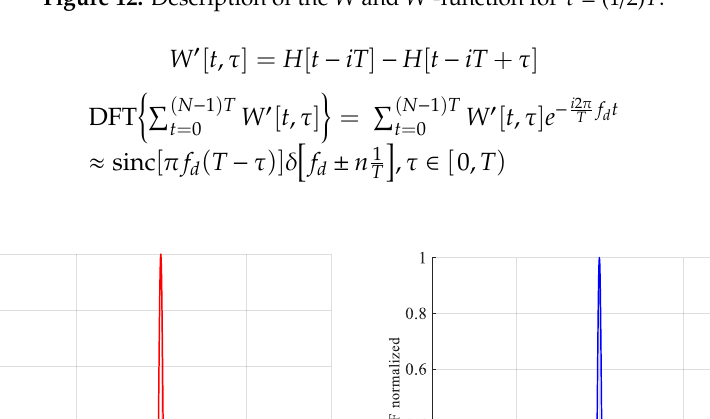
Figure 12. Description of the W and W ’-function for τ = (1 / 2) T .